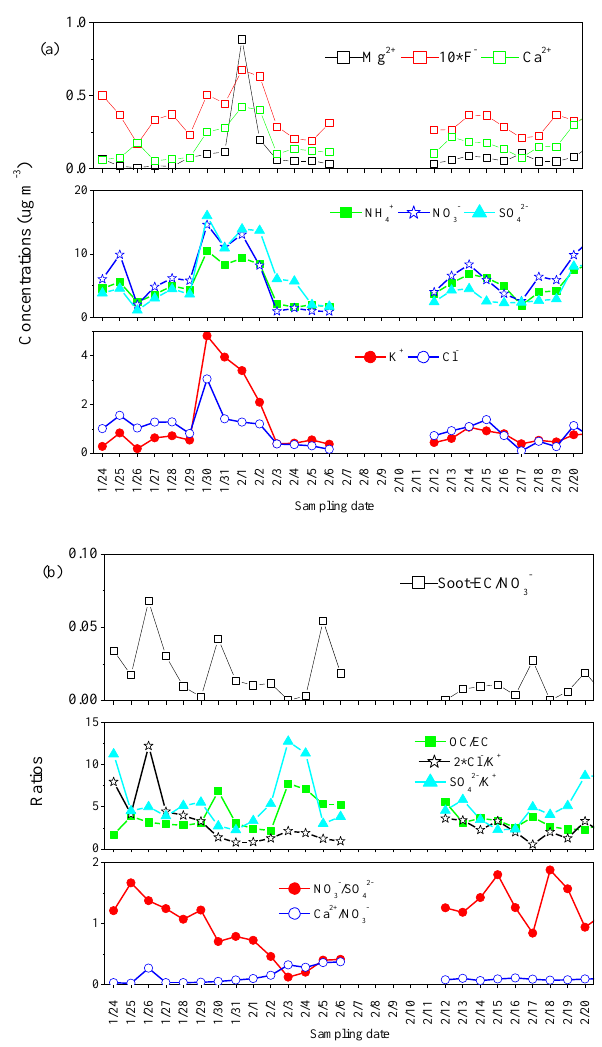
Figure 11. Time series of ions (a) and specific ratios (b) during sam- pling period. 30 January–7 February represents the Chinese Spring Festival in 2014; 30 January is the Chinese New Year day; 14 Febru- ary is the Lantern Festival